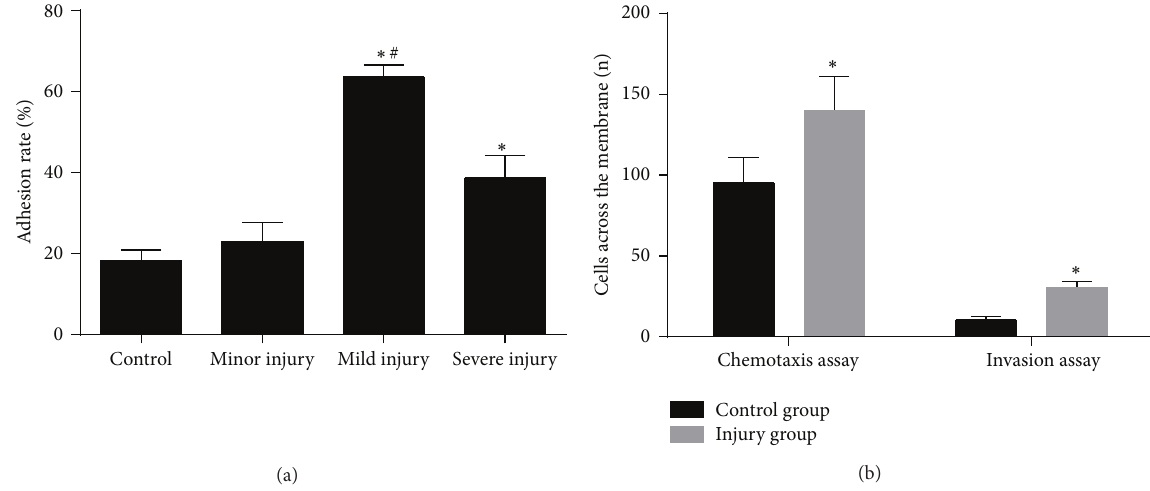
Figure 2: Scratch-injured human umbilical vein endothelial cells (HUVECs) supernatants induce THP-1 cells activation. (a) Results of the adhesion assay. (b) Results of the chemotaxis and invasion assays. ∗ 𝑃 < 0.05 compared with control group; # 𝑃 < 0.05 compared with severe injury